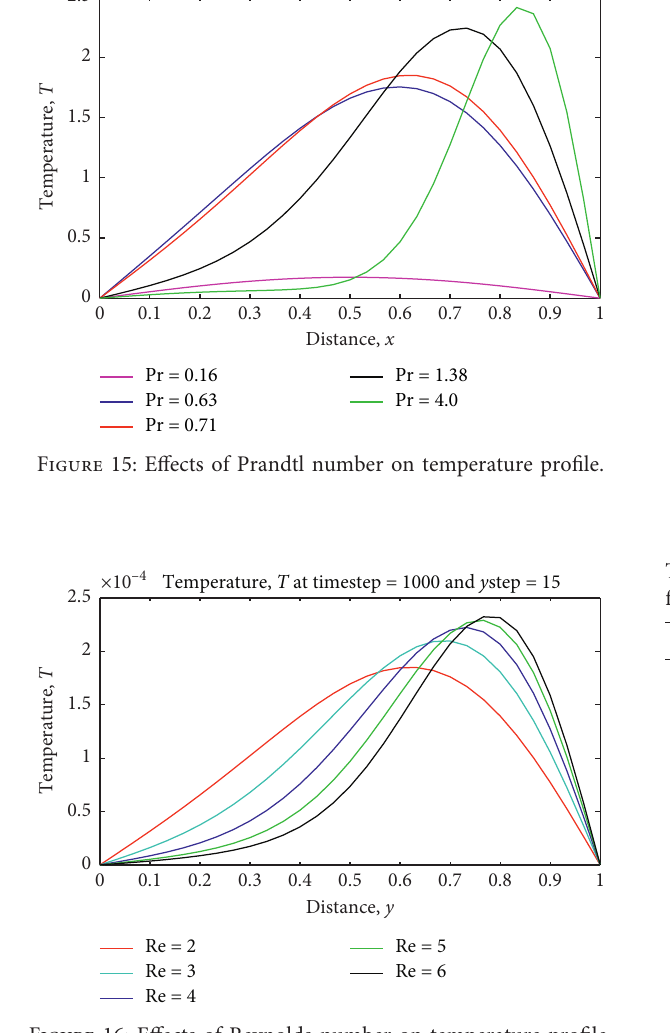
Figure 16: Effects of Reynolds number on temperature profile.